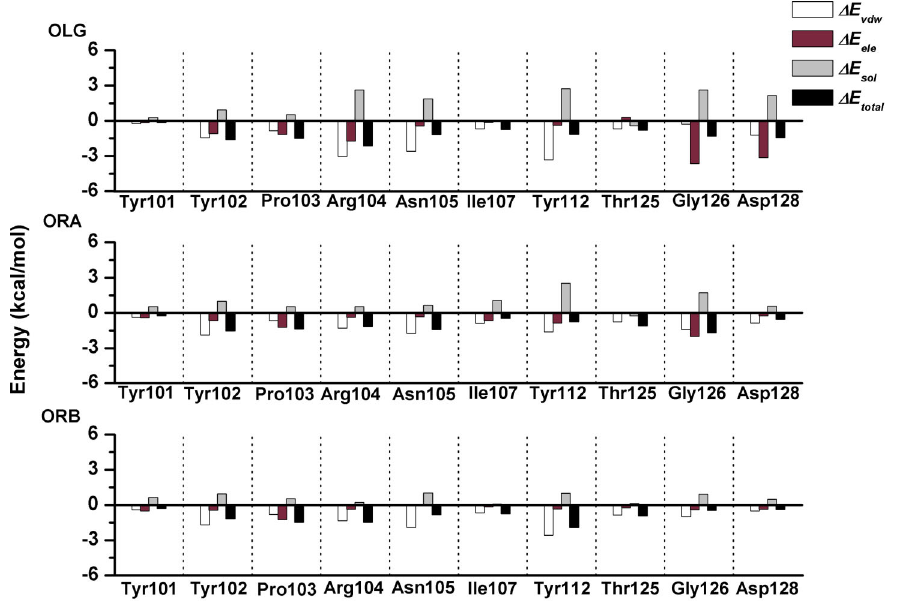
Figure 5. Summed energies of interaction between the inhibitors and a -HL. The histogram shows the van der Waals, electrostatic, salvation and total contributions for the complexes.